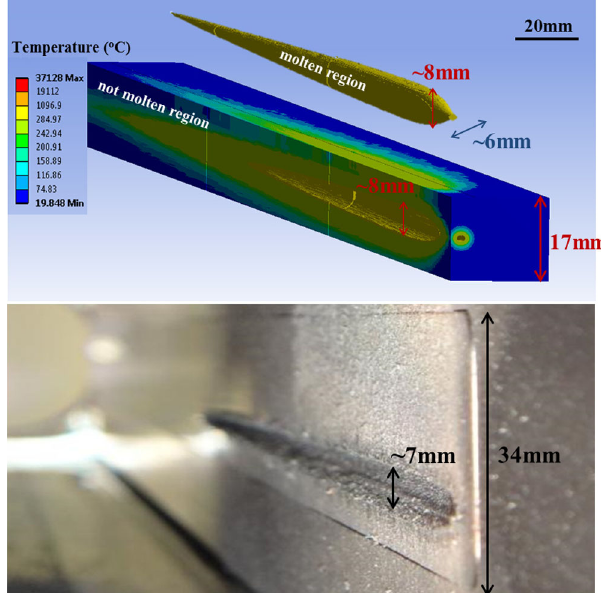
FIG. 23. The extent of the molten region caused by Test 3 beam impact, resulting in a groove on the bottom half of the first two Inermet 180 insert blocks, as simulated by ANSYS ® on the right jaw. It can be observed that the volume of molten material inside the insert extends partly to the third insert block. Marked dimensions of the grooves only take into account the estimated height of the groove.